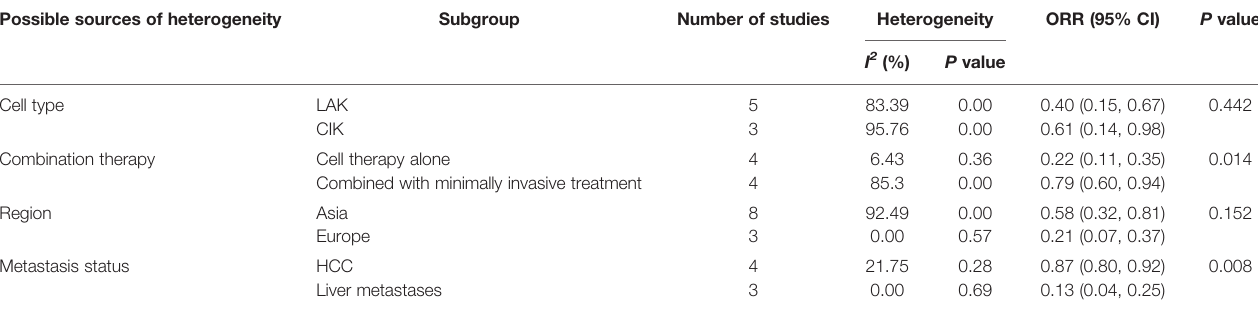
TABLE 3 | Subgroup analysis of ORR.